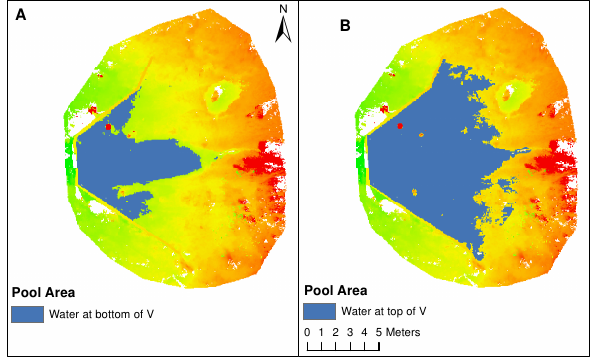
Fig. 4. Calculated areal extent of weir-pool. (A) Water level at bot- tom of V-notch in weir. (B) Water level at top of V-notch in weir.